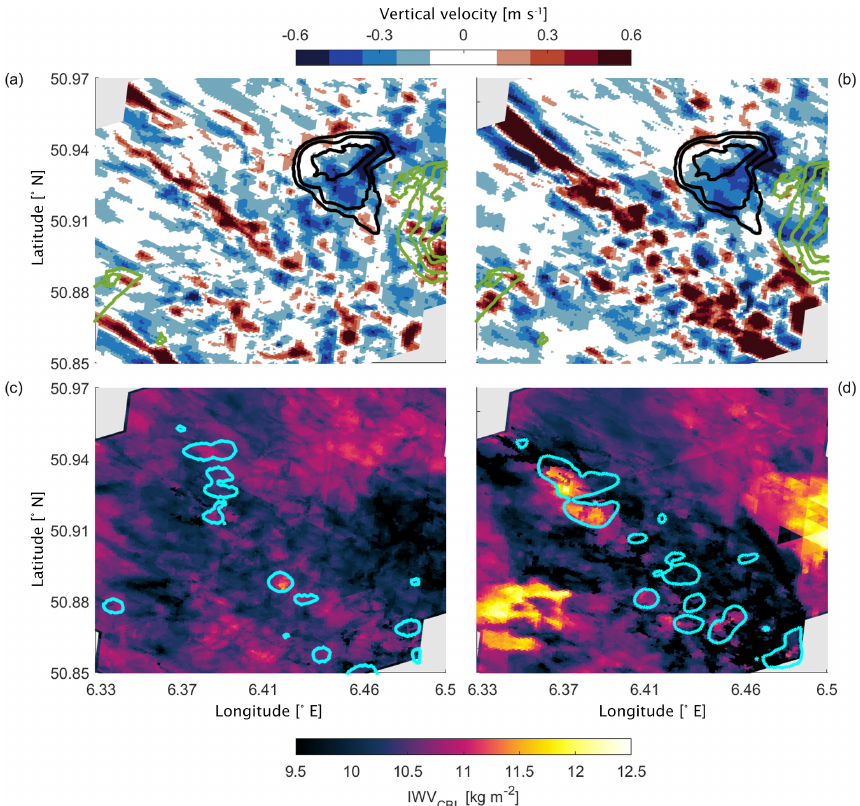
Figure 7. ICON-LEM vertically averaged vertical velocity (a, b) and integrated humidity (c, d) up to the CBL height of the ICON1 (a, c) and ICON2 (b, d) simulations. Contours in panels (a) and (b) refer to the topography relative to JOYCE in ma.s.l. between − 200 and 0m (green) and 0 to 200m (black) in 50m steps. Contours in panels (c) and (d) show areas with total column integrated cloud water values above 10gm − 2 . The results are averaged between 12:00 and